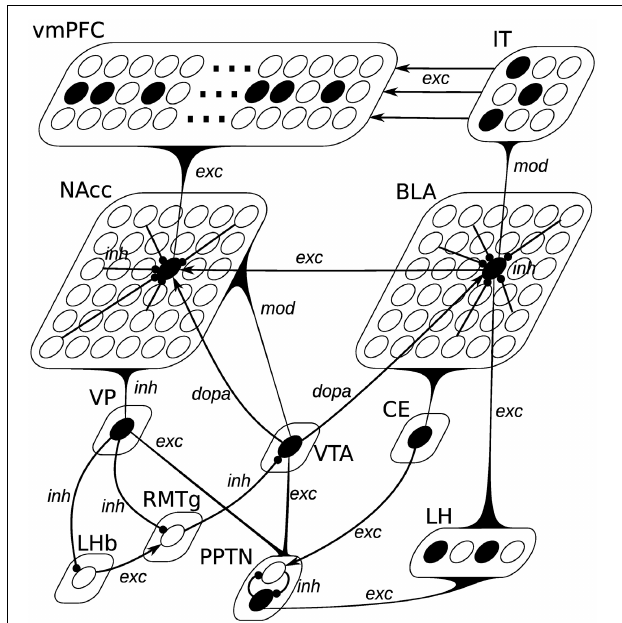
FIGURE 3 | Neural network description of the model. Pointed arrows represent excitatory or dopaminergic synapses, while rounded arrows represent inhibitory synapses. The black curved triangles represent connections from all units of a given population to a single cell. The type of the connection (exc, mod, inh, dopa) is added next to the arrow. Lateral inhibitory connections within BLA and NAcc are only partially represented for simplicity. BLA is composed of 36 units, whose activation is defined by Equation (10). Each unit receives excitatory connections from all LH units ( g exc ( t ) ), modulated connections from all IT units ( g mod ( t ) ), one dopaminergic connection from VTA ( g dopa ( t ) ) and inhibitory connections from all other BLA units ( g inh ( t ) ). Each of the 3 banks of 50 oscillators in vmPFC receives excitatory connections ( g exc ( t ) ) from a specific cluster of three units in IT representing a given CS. NAcc is composed of 36 units, whose activation is defined by Equation (16). Each unit receives a single excitatory connection from BLA ( g exc ( t ) ), excitatory connections from all units of vmPFC ( g mod ( t ) ), one dopaminergic connection from VTA ( g dopa ( t ) ) and inhibitory connections from all other NAcc units ( g inh ( t ) ). The other populations are composed of single units, integrating excitatory or inhibitory